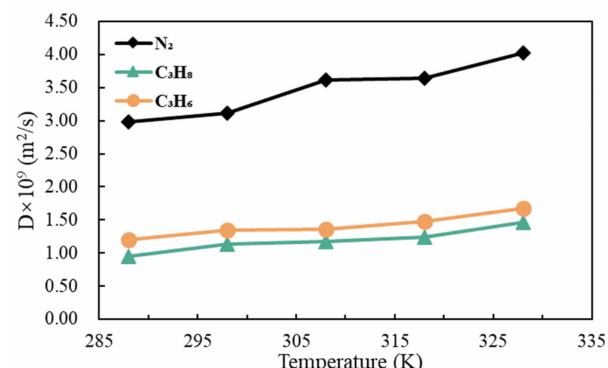
Figure 5. Diffusion coefficients of C 3 /N 2 in PDMS membranes at different